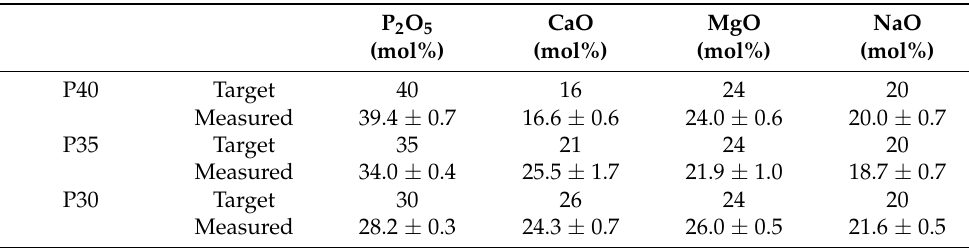
Table 1. EDX measurements of glass compositions against target formulation (mol%) ± standard error of the mean (SEM). P 2 O 5